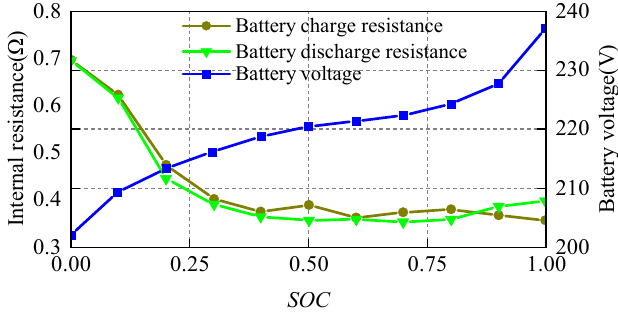
Figure 5. Battery parameters.